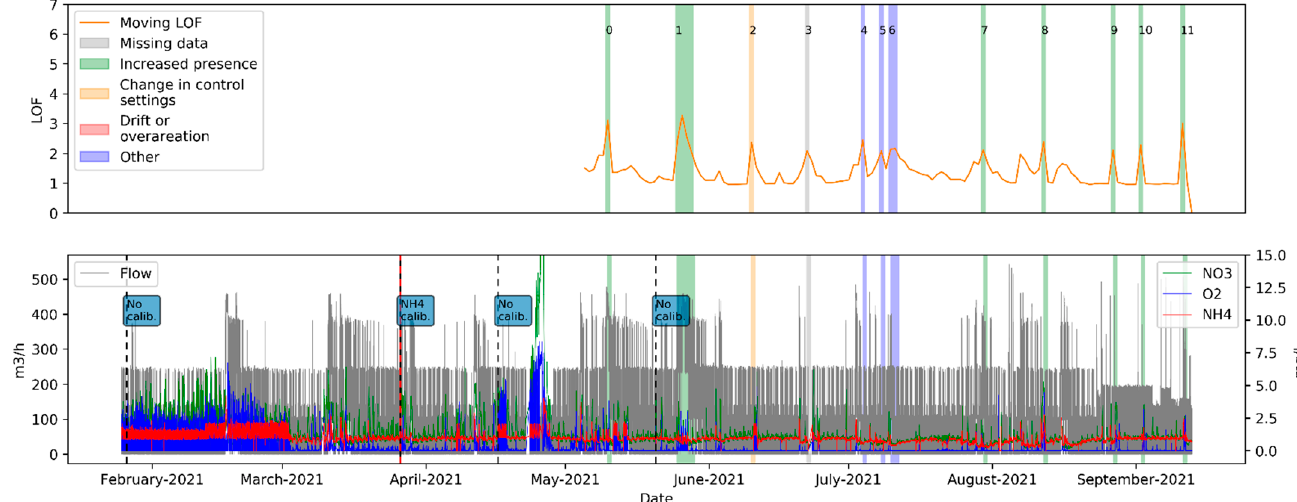
Figure 1. WWTP1 PCT1. In the upper graph, the orange line shows the Moving LOF and the coloured areas, numbered from 0 to 11, show anomalies detected when the Moving LOF exceeded the threshold of two. The lower graph shows the flow, NO 3 , DO and NH 4 and the calibration data available from the plant.